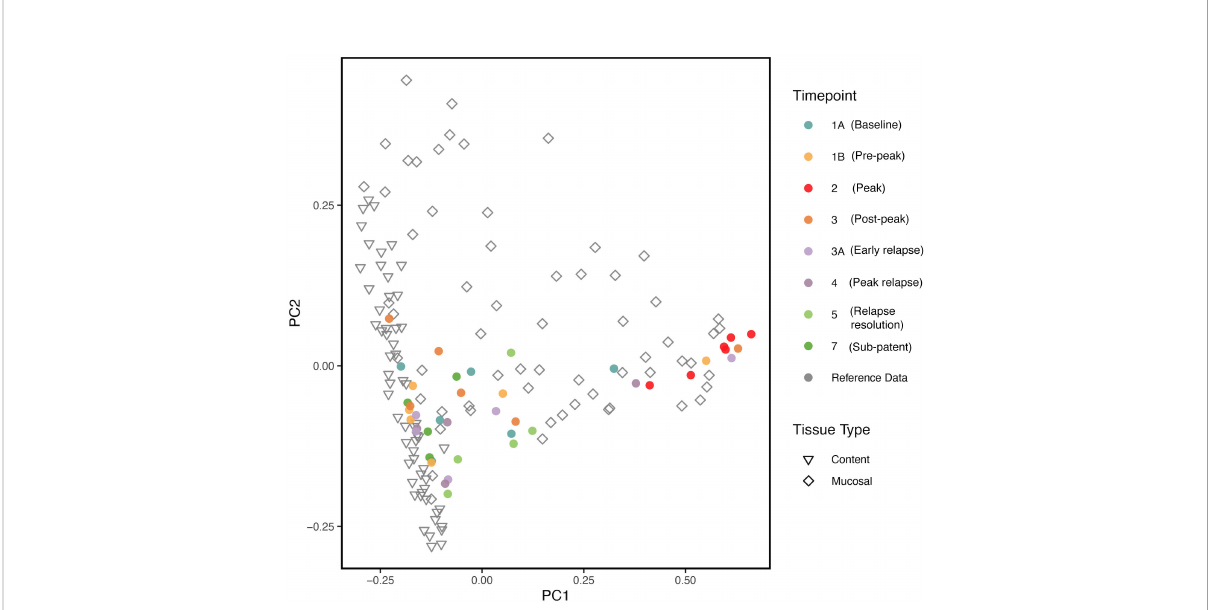
FIGURE 6 PCoA plot comparing, at various TPs, the gut microbial communities from the longitudinal P. cynomolgi infections, with previously published data on the lumen and mucosal bacterial diversity in rhesus macaques. Each marker represents one sample, and the colors are depictive of the different TPs. PCoA indicates that microbiome samples from peak infection (TP2) are more similar in microbial composition to healthy mucosal samples than healthy luminal samples.